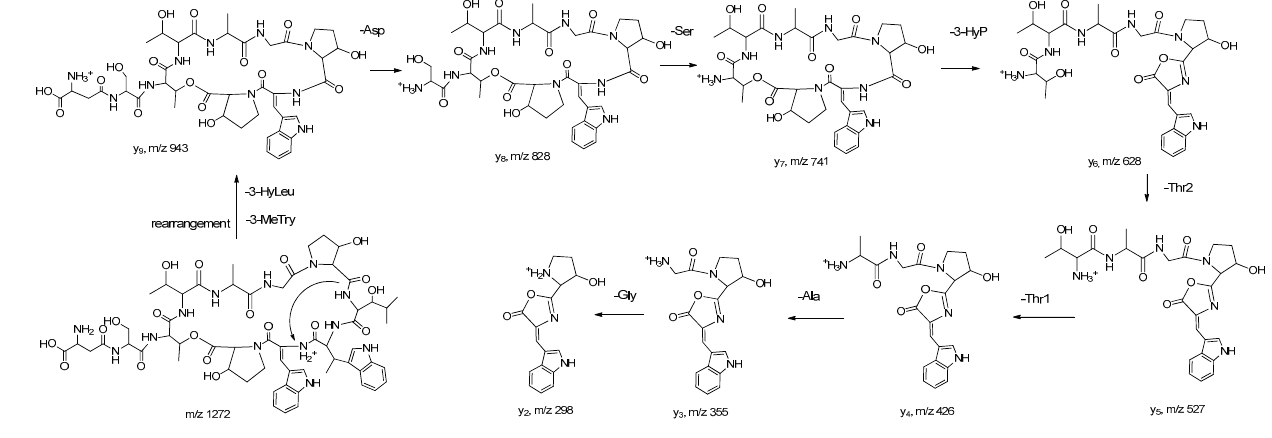
Figure 2. Fragmentation pathway of the m / z 943